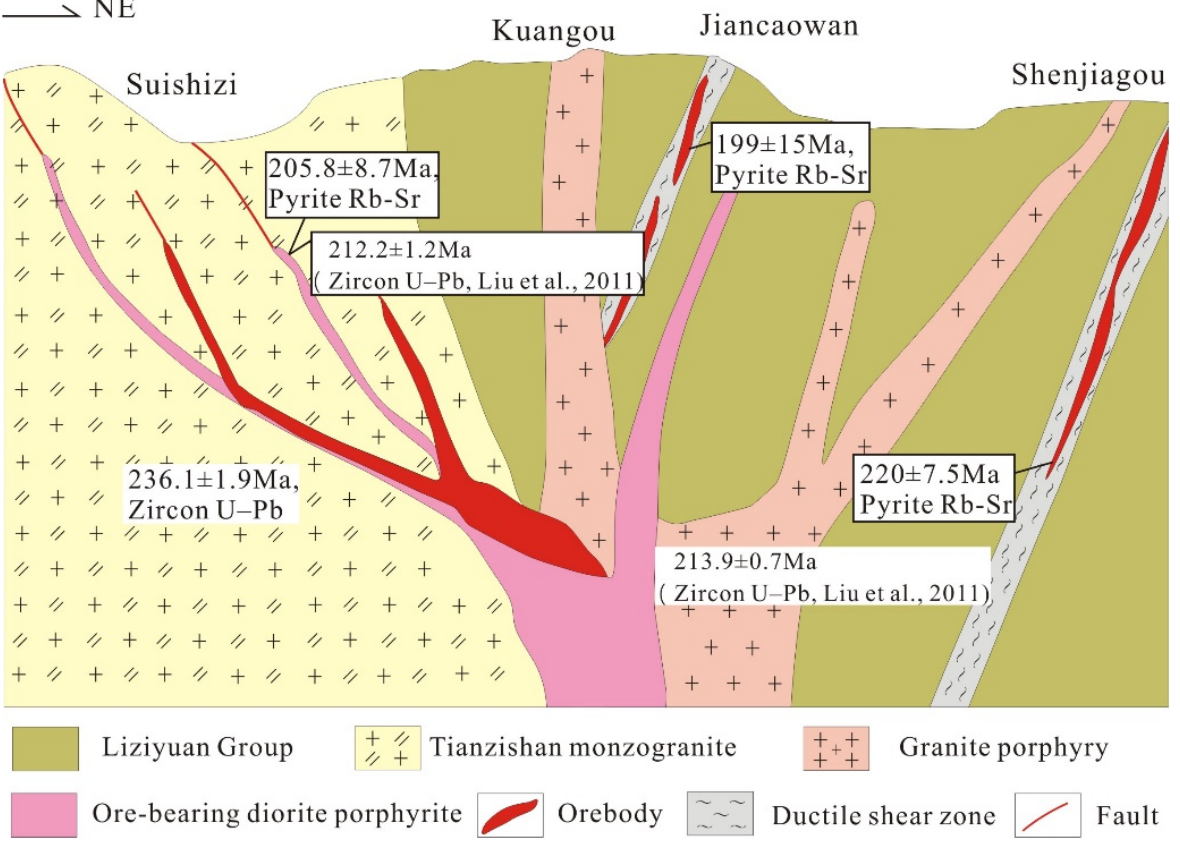
Figure 14. Metallogenic model of Liziyuan Au deposit.